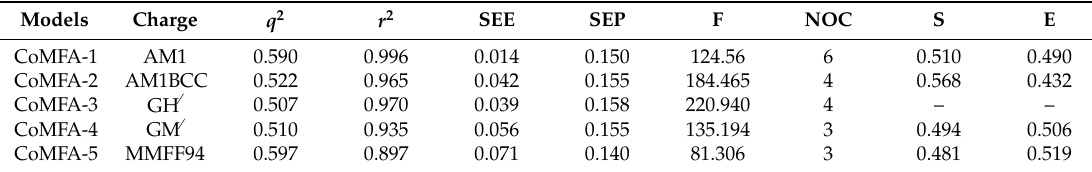
Table 1. Partial least square (PLS) statistics summary of CoMFA models in combination with different charges methods.